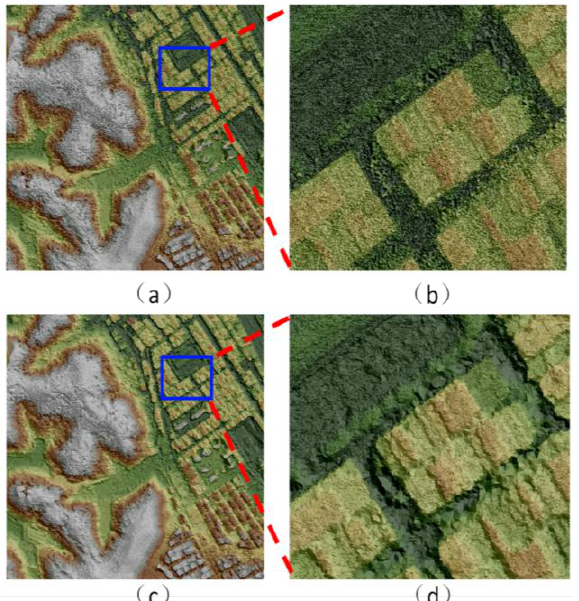
Figure 7. Cross section of dataset 2 before and after merging. (a) Overview of dataset 2, where Area A and Area B are two areas used to show the merging results; (b) Cross section of Area A before merging; (c) Cross section of Area A after merging; (d) Cross section of Area B before merging; (e) Cross section of Area B after merging.